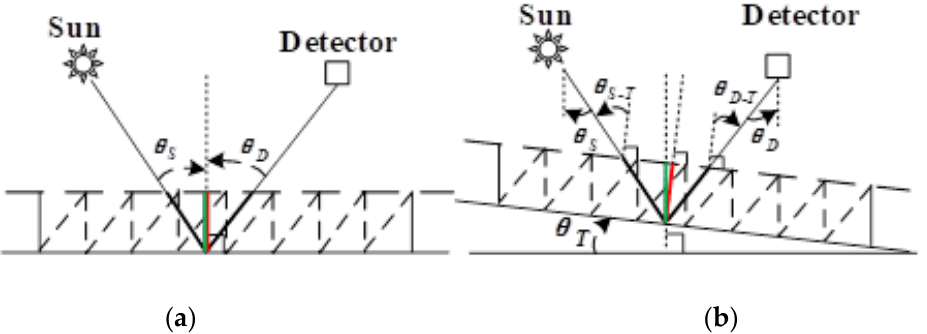
Figure 2. Path length of a (solar) beam through a canopy: ( a ) canopy on a horizontal surface; ( b ) canopy on an inclined surface. Green bold lines represent the path length along the zenith direction; it has unit magnitude. Red bold lines represent the path length along the direction normal to the vegetation canopy; its magnitude is cos( 𝜃 T ). Black bold lines represent the path length (S) along an arbitrary direction in the vegetation canopy.